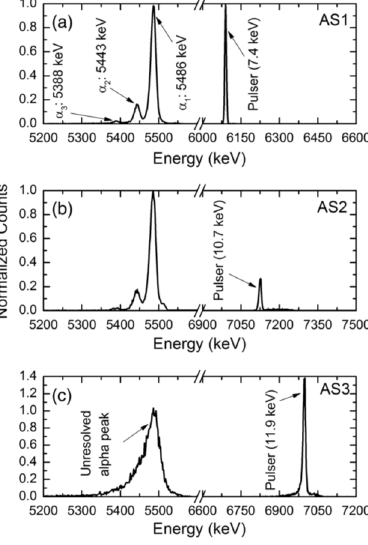
Figure 25. Pulse height spectra obtained using a 241 Am point alpha source for detectors ( a ) AS1, ( b ) AS2, and ( c ) AS3.